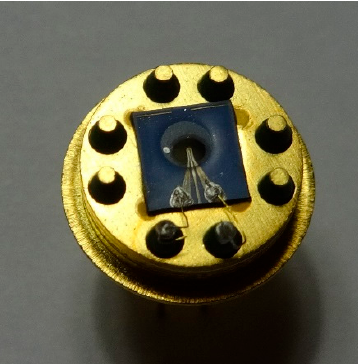
Figure 3. LTCC MEMS with 20 μ m thick cantilever laser shaped